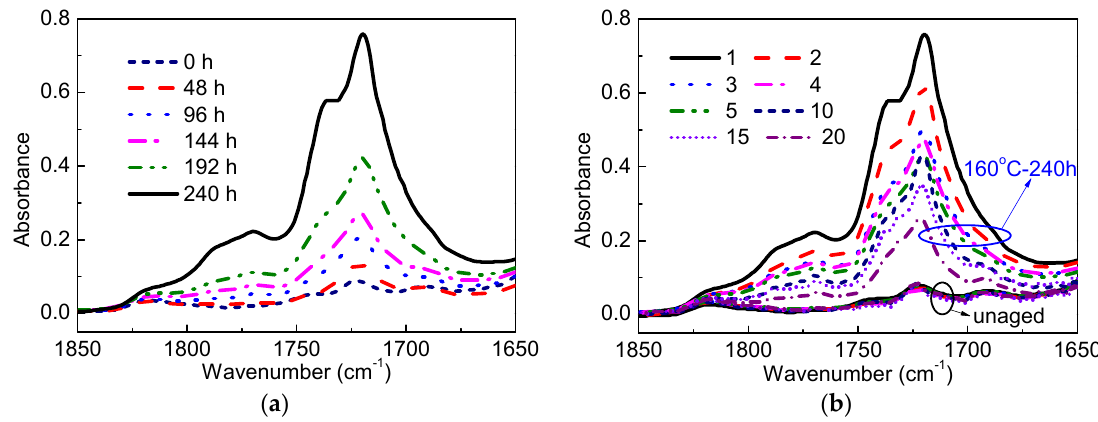
Figure 7. ( a ) FTIR spectra of the No.1 sample as a function of ageing time; ( b ) FTIR spectra of unaged and aged for 240 h XLPE samples at different positions.